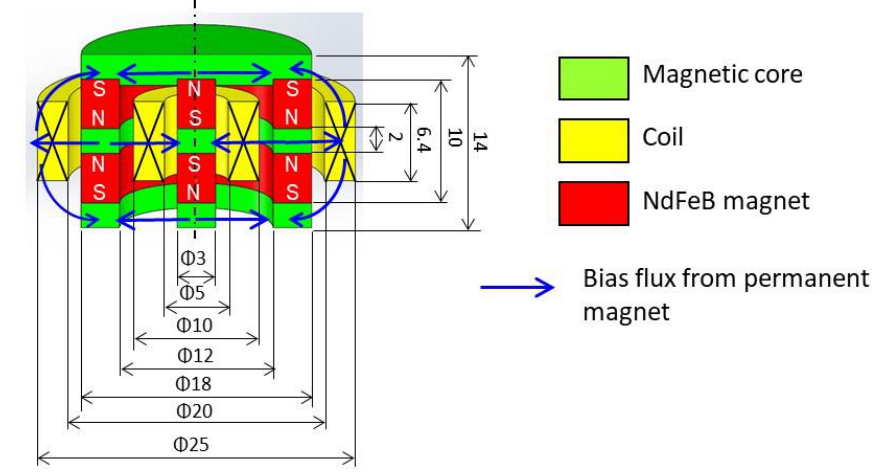
Figure 5. The design and dimensions of the VCM. The inner and outer coils effectively use the lateral magnetic flux from the permanent rings.